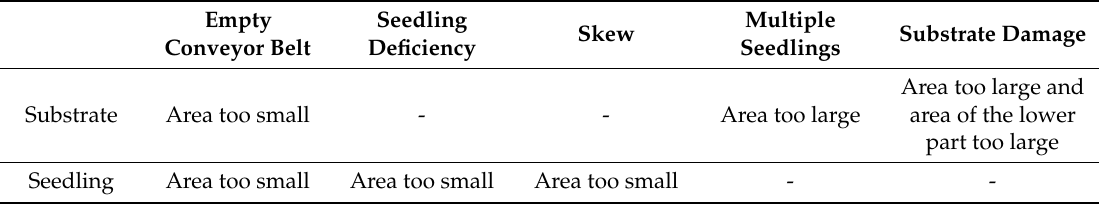
Table 2. The substrate and seedling feature of cabbage seedling